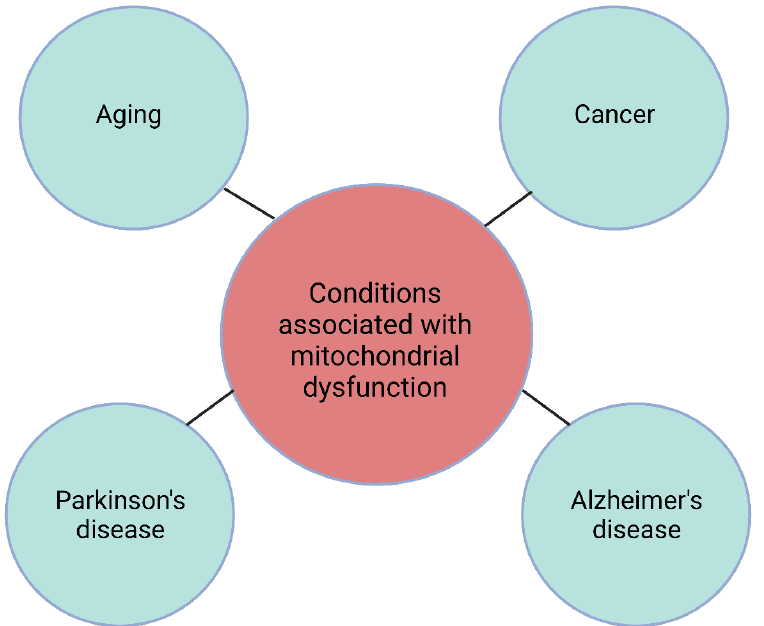
Figure 4. Conditions associated with mitochondrial dysfunction. An accumulation of deletions of mtDNA is observed in P arkinson’s disease patients, Alzheimer’s disease patients, and in the normal aging process, and abnormal mitochondrial structure and function have been observed in the brains of Alzheimer’s patients. Parkinson’s and Alzheimer’s tissues also show a decrease in absolute mtDNA copy number, indicating that damaged mitochondrial genome copies are not being suffi- ciently restored to normal levels in these conditions. Mitochondrial mutations have been linked to a wide variety of cancers and appear to drive metastasis through accelerated mutagenesis driven by mitochondrial dysfunction and ROS production. Preliminary studies in our lab show that a single treatment with dye and 660 nm light reduces the growth of our HEK293 TFAM-FAP cells, as measured by CyQuant. We have also observed mitochondrial dysfunction after multiple treatments with light plus dye, specifically, uncoupled mitochondrial function as measured in the Seahorse extracellular flux analyzer. Future studies involve quantifying the level of 8-oxoG lesions in mtDNA with quantitative long-amplicon PCR [14] following dye + light treatment. With the pre- cise temporal and spatial control of the TFAM-FAP system, we can subject mtDNA to different levels and patterns of ROS exposure to answer the questions asked previously in this article: namely, are dysfunctional and/or damaged OXPHOS components generat- ing ROS that then preferentially target mtDNA, or is damaged mtDNA leading to dam- aged OXPHOS components that then generate a vicious cycle of increased ROS and mtDNA damage? What is the nature and severity of mtDNA damage that leads mitochon- dria to degrade their DNA rather than repair it, and what does this mean for the patho- genesis of neurodegenerative diseases and cancer? These questions are placed in the con- text of what is known with regard to several human pathologies associated with mito- chondrial dysfunction in the Section 6. 6. MtDNA Mutations and Pathologies An accumulation of mtDNA deletions has been observed in older people, Parkin- son’s disease (PD) patients, and Alzheimer’s disease (AD) patients [40]. The substantia nigra of PD patients and older individuals exhibited clonal expansion of deleted mtDNA,